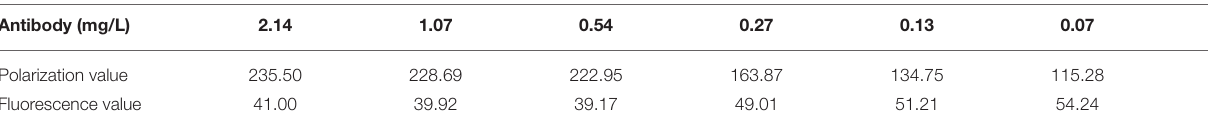
TABLE 2 | The polarization of antibody